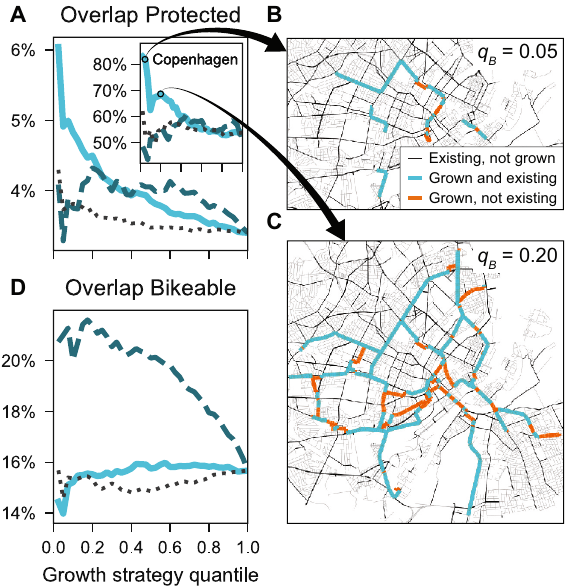
Figure 7. First stages of synthetic growth recreate existing networks. Shown are results for rail station seeds averaged over all cities. Same legend as Fig. 4. ( A ) Growth by betweenness starts with high, then decreasing overlap with existing protected bicycle infrastructure. Inset: The effect is especially strong in cities with well developed on-street bicycle networks such as Copenhagen. Here the growth algorithm starts with over 80% overlap. ( B ) Map of this high overlap in Copenhagen at the quantiles q B = 0.05 and ( C ) q B = 0.20 . ( D ) The overlap with bikeable infrastructure has a notable effect only for growth by closeness due to traffic-calmed city centers: With increasing distance from the city center, overlap falls. Maps created with: https:// github. com/ mszell/ biken wgrow th